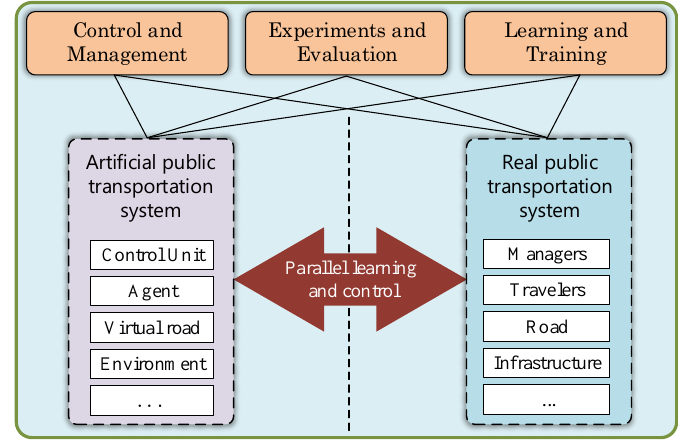
Figure 3. The ACP based Artificial System construction.